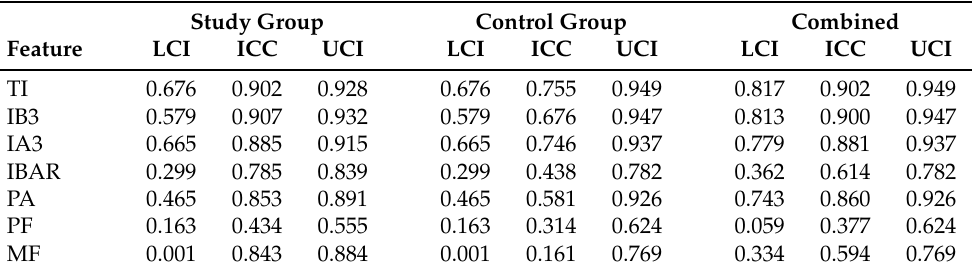
Table A2. Intraclass correlation coefficients (ICC) for each feature computed on norm1 -normalized spectrum with corresponding 95% confidence intervals (CI).